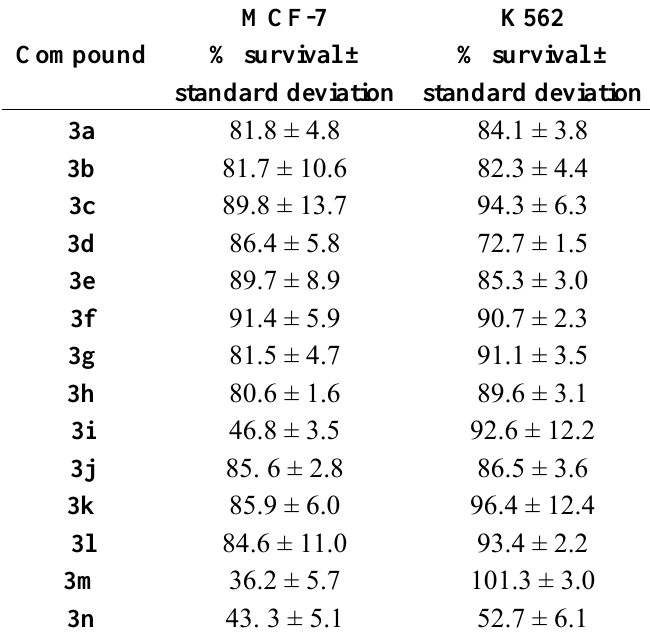
Table 1. Percentage cell survival of MCF-7 and K562 cells following 72 hours exposure to 50 μ M f all compounds.